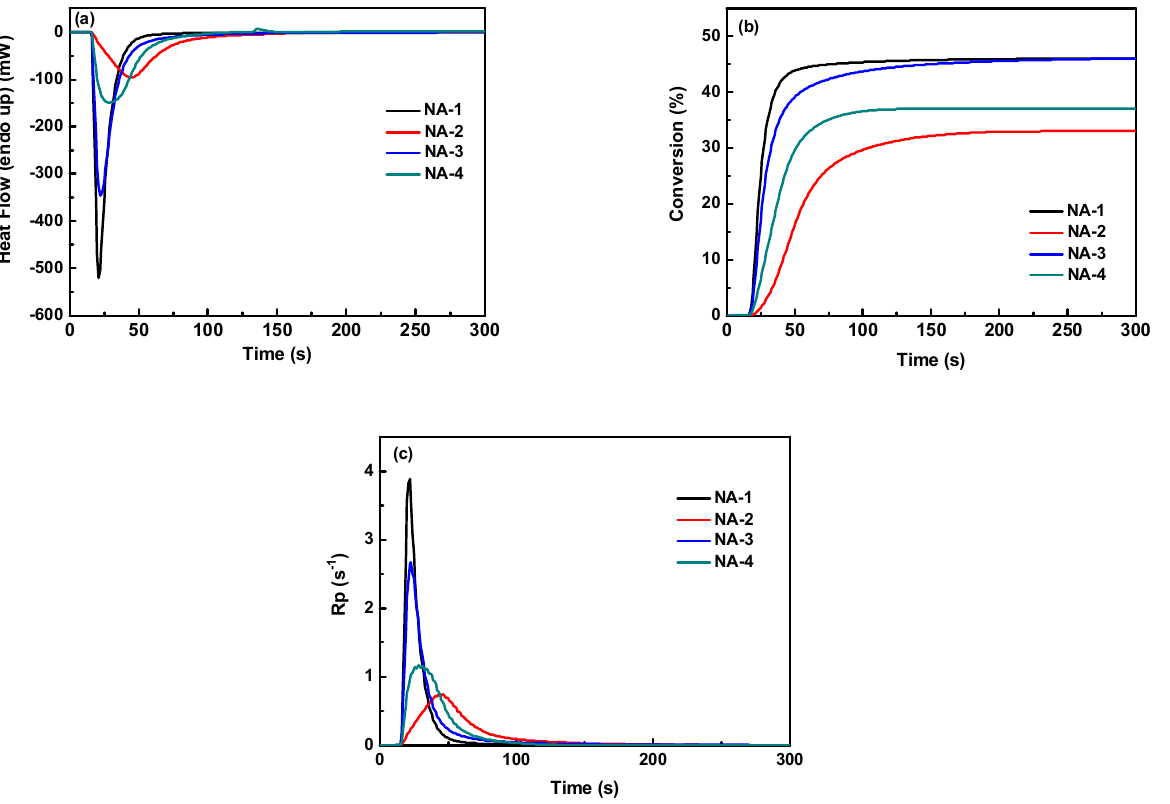
Figure 6. ( a ) Heat flow, ( b ) degree of conversion, and ( c ) Rp versus time of TMPTA photopolymerization initiated by naphthalene oxime esters (2 wt%) under UV light irradiation in 180 mW cm − 2 . The irradiation began at t = 24 s.